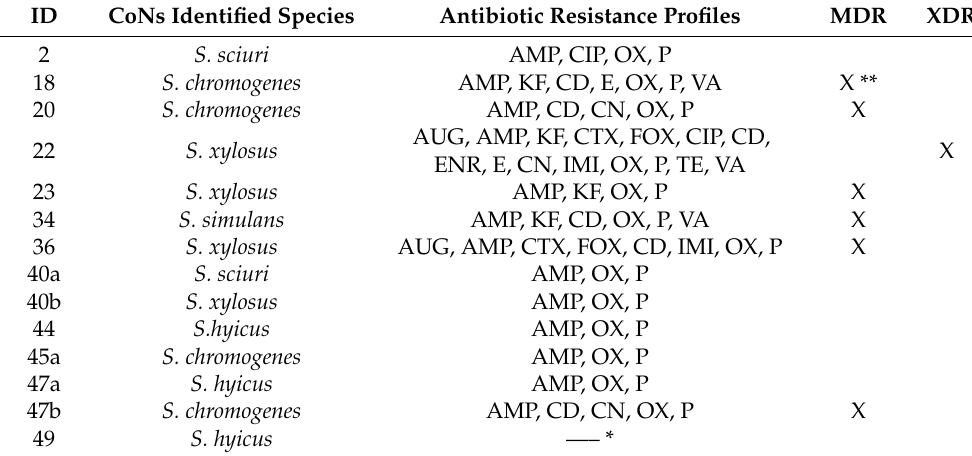
Table 2. Antibiotic resistance phenotype of isolated CoNS